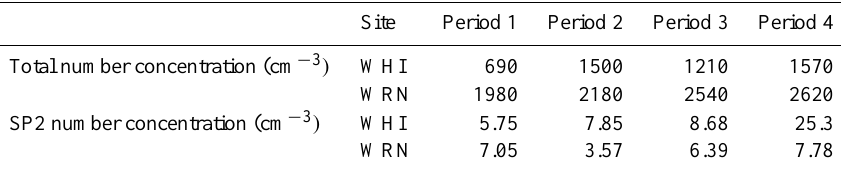
Table 3. Median concentrations of the integrated total particle number from the SMPS and BC from the SP2 during each period for the two sites.